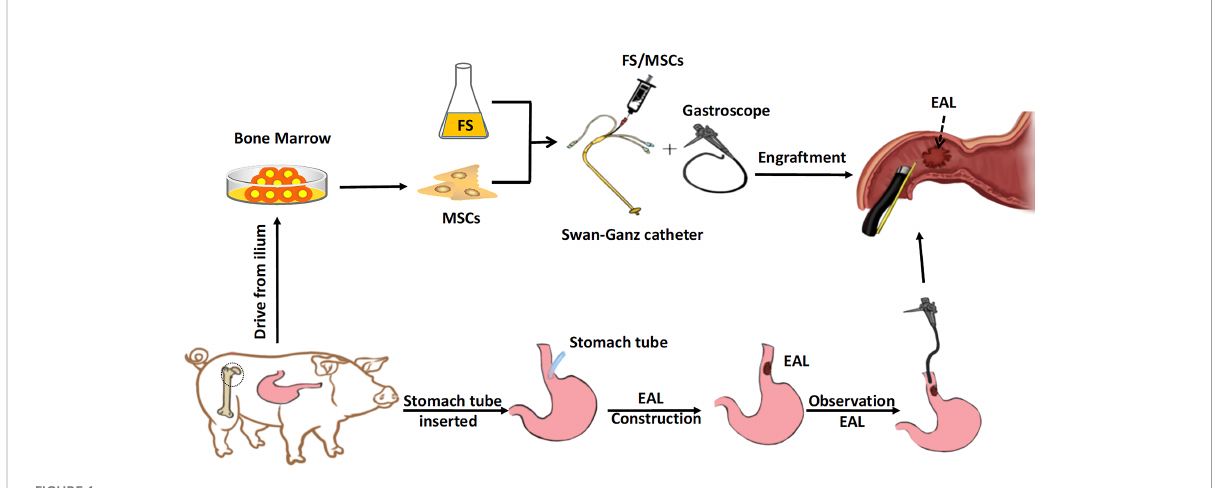
FIGURE 1 Schematic of the experiment. The MSCs derived from the bone marrow were engrafted in FS via a gastroscope for EAL treatment. EAL, esophageal anastomotic leakage; MSCs, mesenchymal stromal cells; FS, fi brin